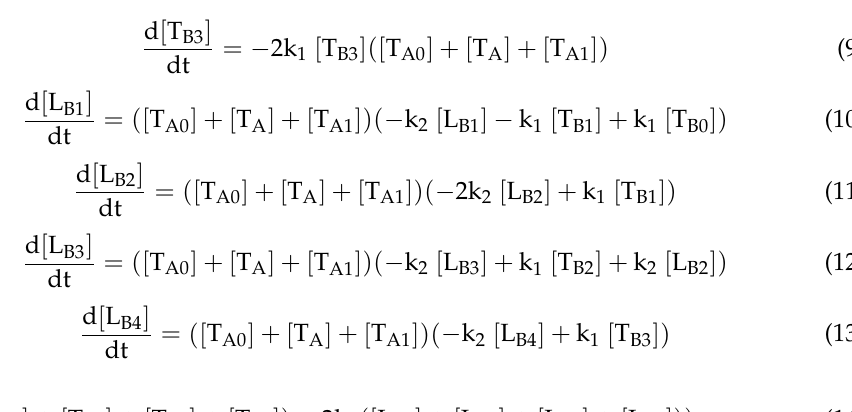
Figure 4. The elementary reactions for cycloaddition of AB 2 + A 2 + B 4 monomer mixture with the substitution effect of B groups.